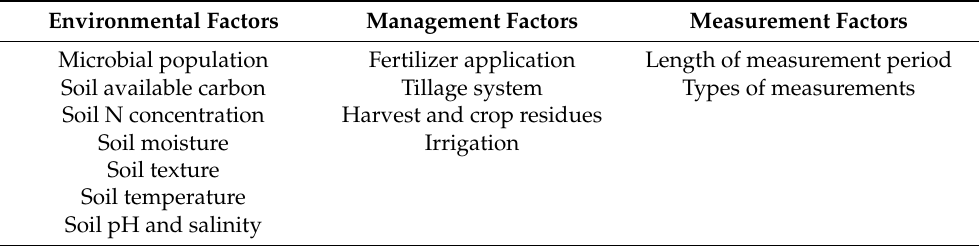
Table 1. Impact factors that directly and indirectly influence N 2 O emissions from managed